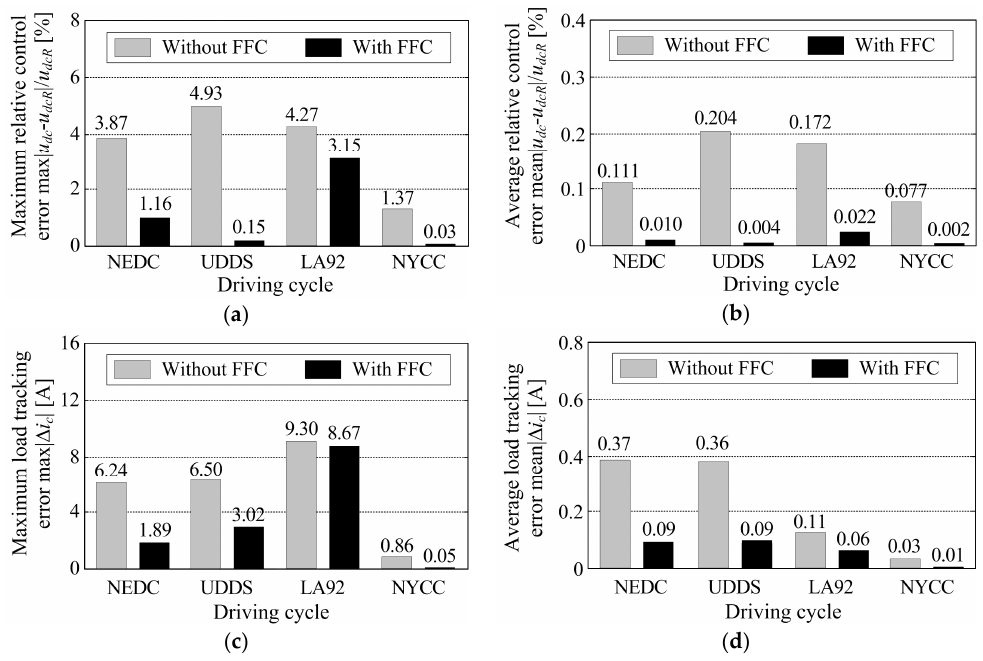
Figure 13. DC bus voltage maximum error ( a ) and average error ( b ), load current maximum tracking error ( c ) and average tracking error ( d ) quality indices for NEDC, UDDS, LA92, and NYCC driving cycles.